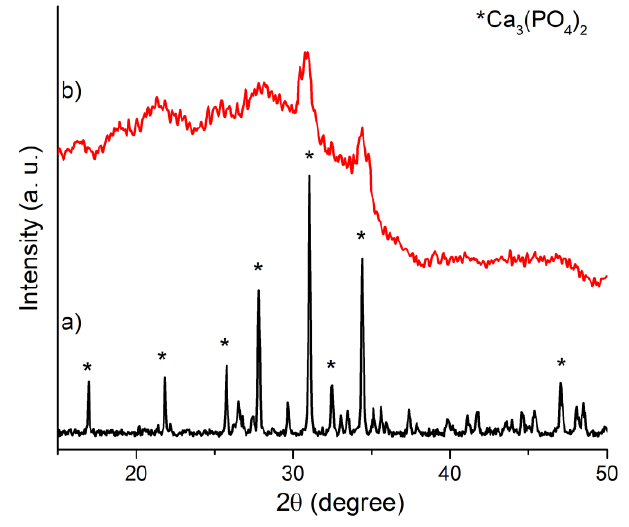
Figure 2. XRD patterns of ( a ) Mn,Sr-TCP target and ( b ) Mn,Sr-TCP coating deposited on Si.